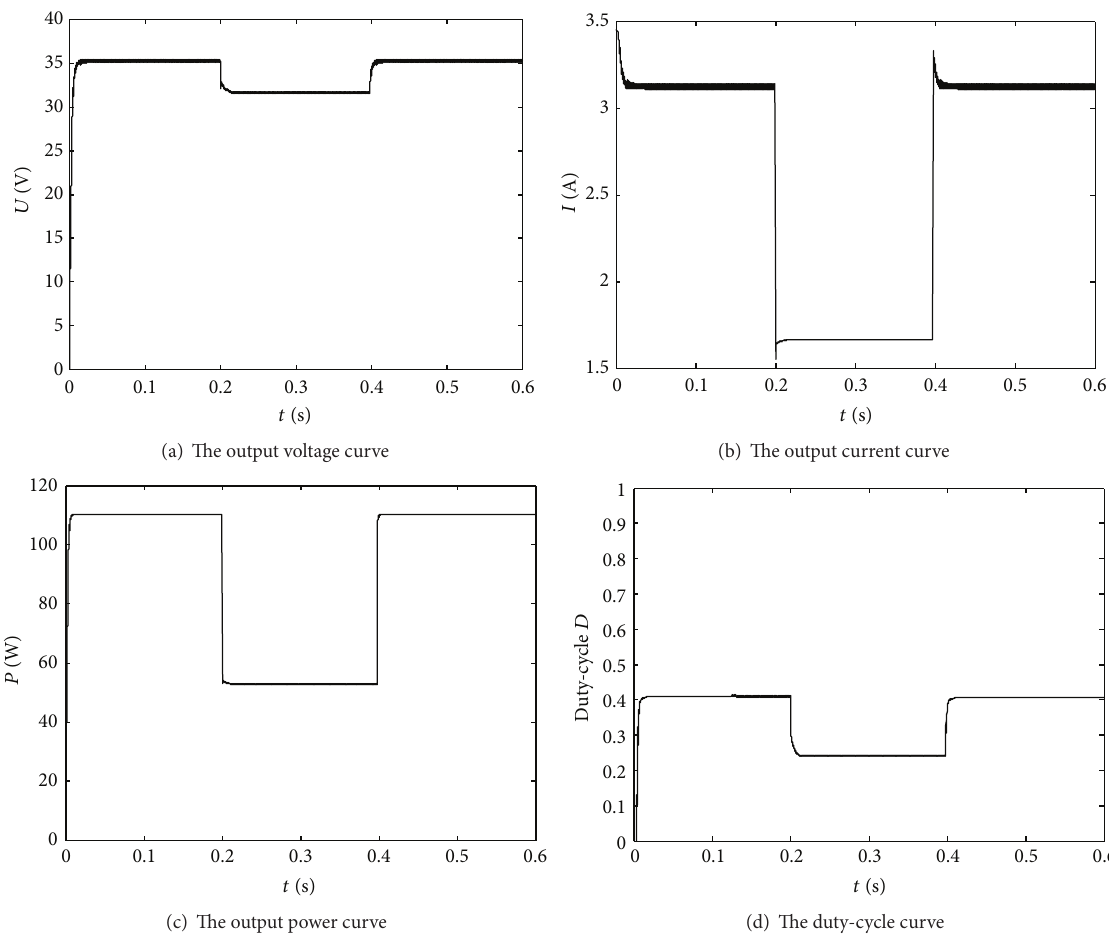
Figure 14: The improved MPPT algorithm